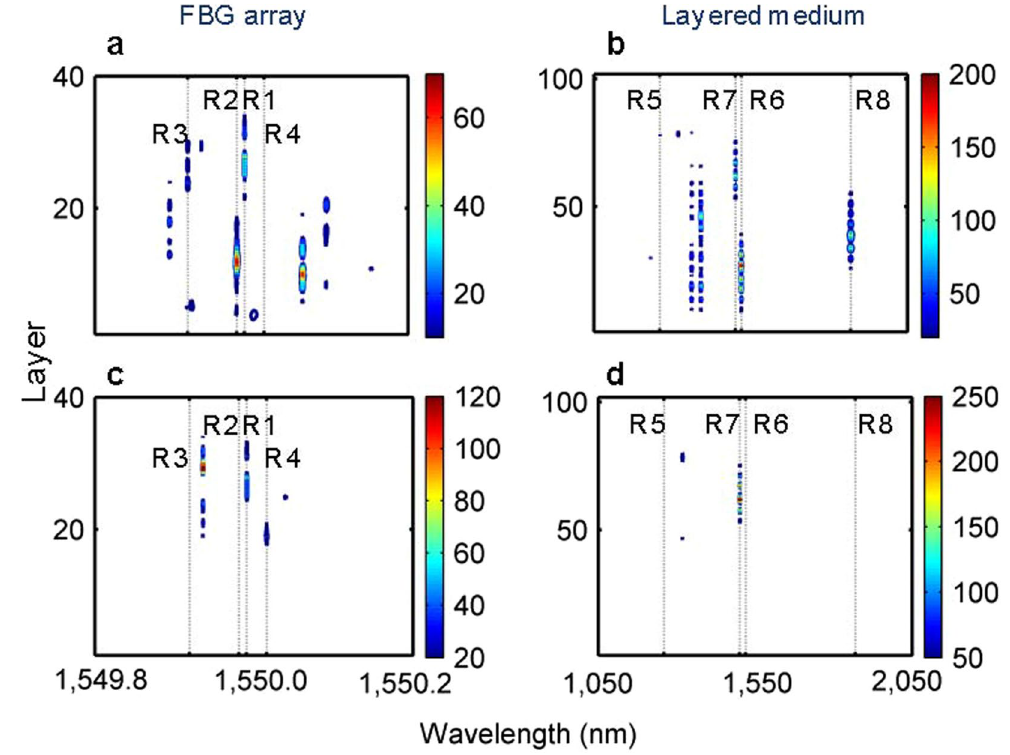
Figure 2. Disorder-induced spatial-frequency bi-directional high-intensity concentrations. (a ) Left-incident intensity in the FBG array. ( b ) Left-incident intensity in the layered medium. ( c ) Right-incident intensity in the FBG array. ( d ) Right-incident intensity in the layered